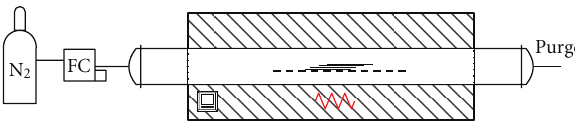
Figure 1: Scheme of the pyrolysis set-up.